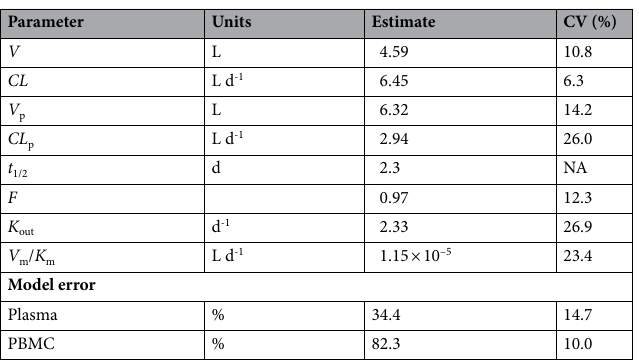
Table 2. Model describing the systemic PK parameters for TFV, using IV and SQ co-modeling. V , Volume of distribution of the central compartment; CL , Total body clearance; V p , Volume of distribution of the second compartment; CL p , Clearance from the second compartment; t 1/2 , Elimination half-life; F , Bioavailability/ exposure scaling; K m , Maximum rate achieved by the system using Michaelis–Menten kinetics; K m , Michaelis constant; multiplicative error, error that is proportional to concentration.